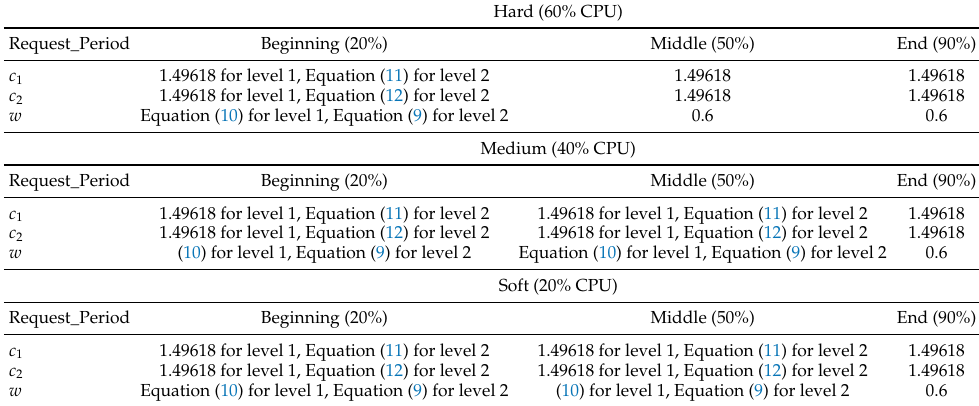
Table 3. PSO parameters.